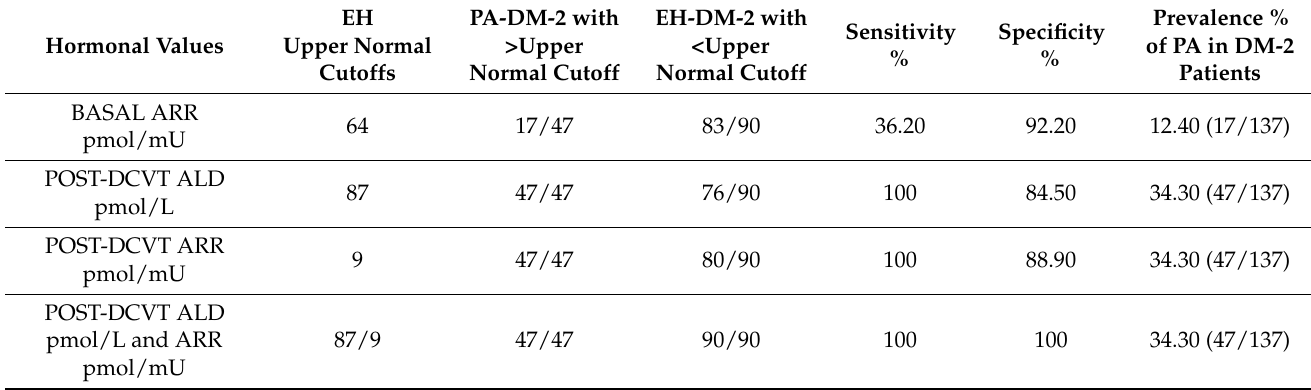
Table 3. Normal cutoffs, performance characteristic of the tests, and PA prevalence in DM-2